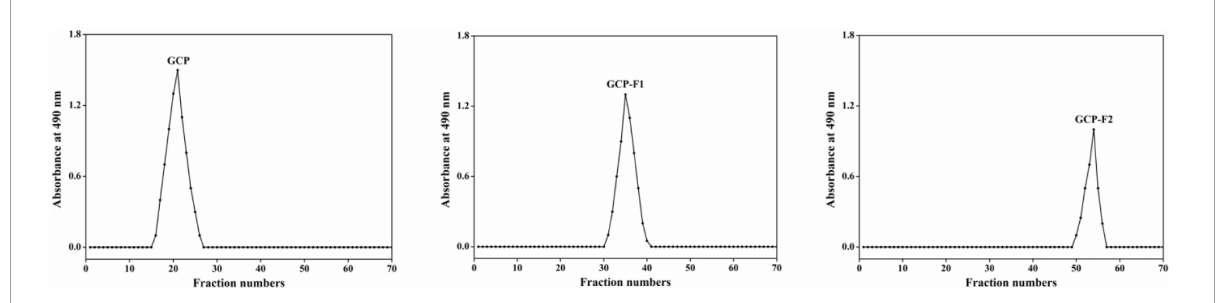
FIGURE1 Elution curve of Genistein Combined Polysaccharide (GCP), GCP-F1, and GCP-F2 on Sepharose CL-6B column (2.5 cm × 60